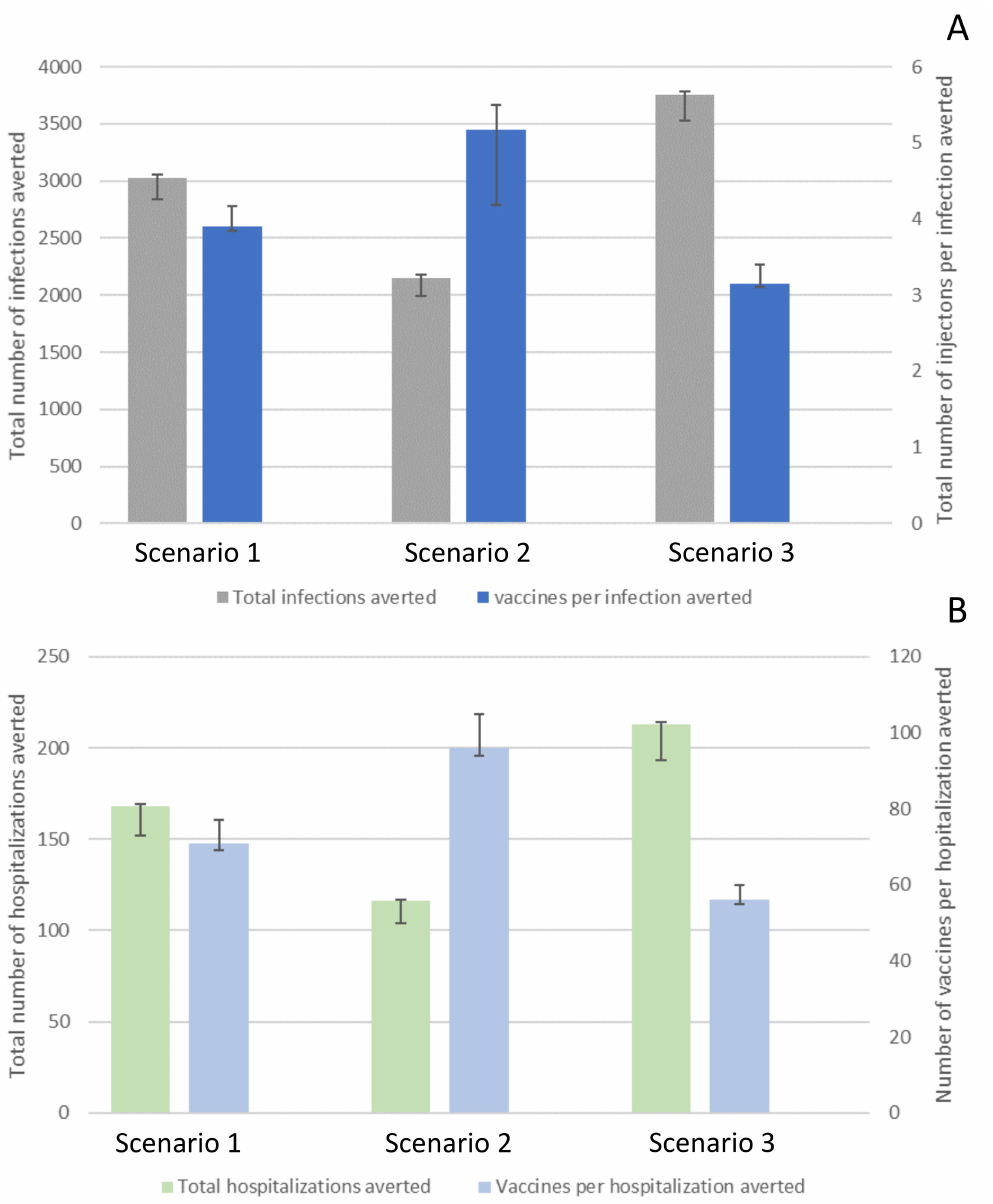
Figure 2. Impact of different vaccination scenarios on COVID-19-related infections (Panel A ) and hospitalizations (Panel B ). The effect was defined in averted cases, and the number of vaccinations needed per case/hospitalization averted (i.e., population-level effectiveness of a vaccination program). Scenario 1, one-million vaccine doses were distributed homoge- neously across Ohio’s different spatial risk areas. Scenario 2, 60% of all vaccines were administered to Group 3 and Group 4 (i.e., identified as areas with low infection intensity), while 40% of the vaccines were equally distributed across Group 1 and Group 2 (i.e., identified as areas with high infection intensity). Scenario 3, 90% were equally distributed across Group 1 and Group 2, and only 10% of all vaccines were allocated to Group 3 and Group